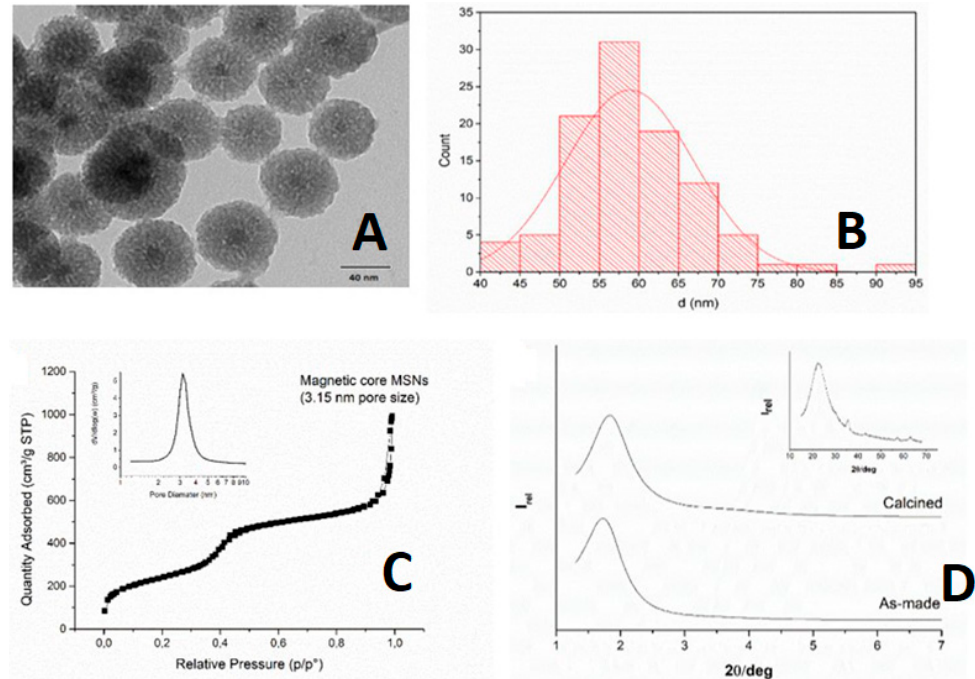
Figure 1. ( A ) Transmission electron microscopy showing the size as the magnetic core of the mesoporous silica nanoparticles. ( B ) Size histogram and normal size distribution of magnetic core mesoporous silica. ( C ) N 2 adsorption-desorption isotherm of magnetic mesoporous silica nanoparticles (MMSN), showing the pore size. ( D ) Powder X-ray diffraction patterns of (bottom)